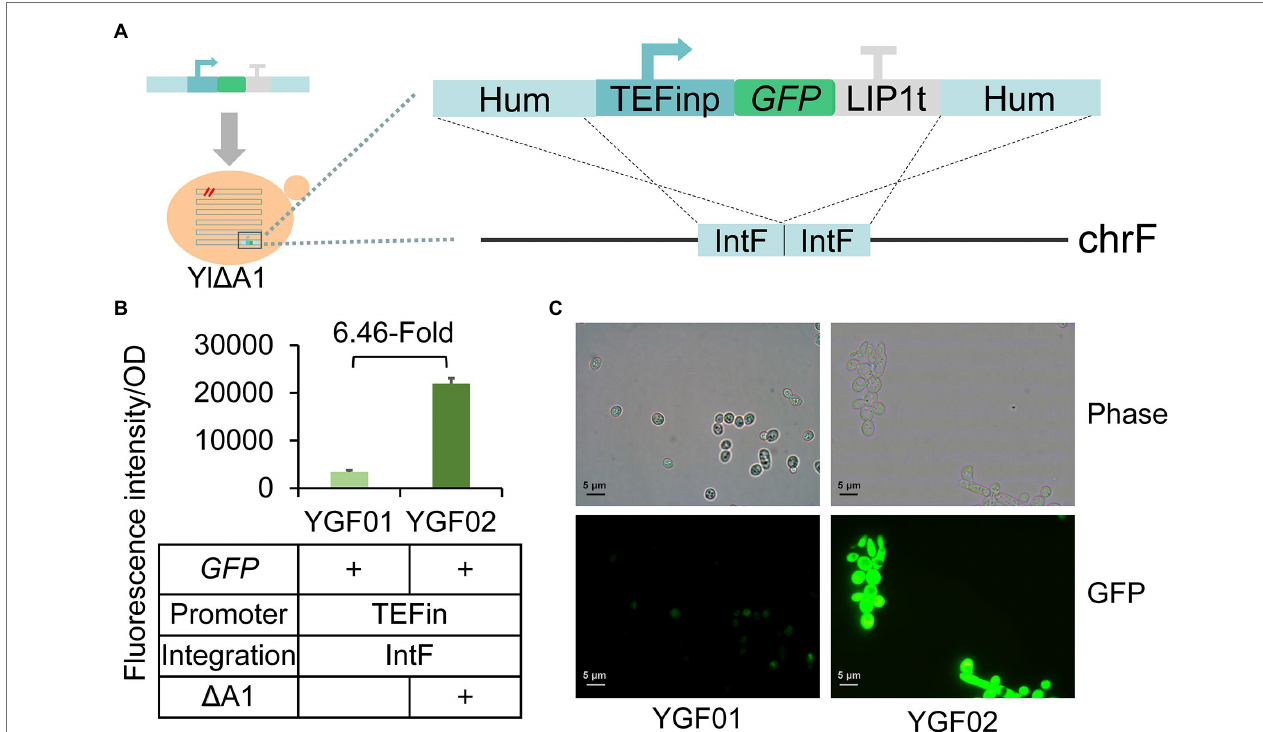
FIGURE 6 | Verification of improved protein expression by sfGFP gene expression. (A) Schematic diagram of the sfGFP insertion cassette used to transform Y. lipolytica . The sfGFP gene was driven by the TEFin promoter and stopped by the LIP1 terminator, flanking by two 500 bp homologous arms to IntF site. (B) The A1 gene disruption increased protein expression. Characterization of protein expression by green fluorescence intensity. All strains were cultured in SC-Leu medium. Values are the mean of three biological replicates ± standard deviation ( n = 3) after 48 h. (C) Fluorescence images of the strains YGF01 and YGF02. The images of sfGFP fluorescence were observed by a fluorescence microscope (Olympus CX41,